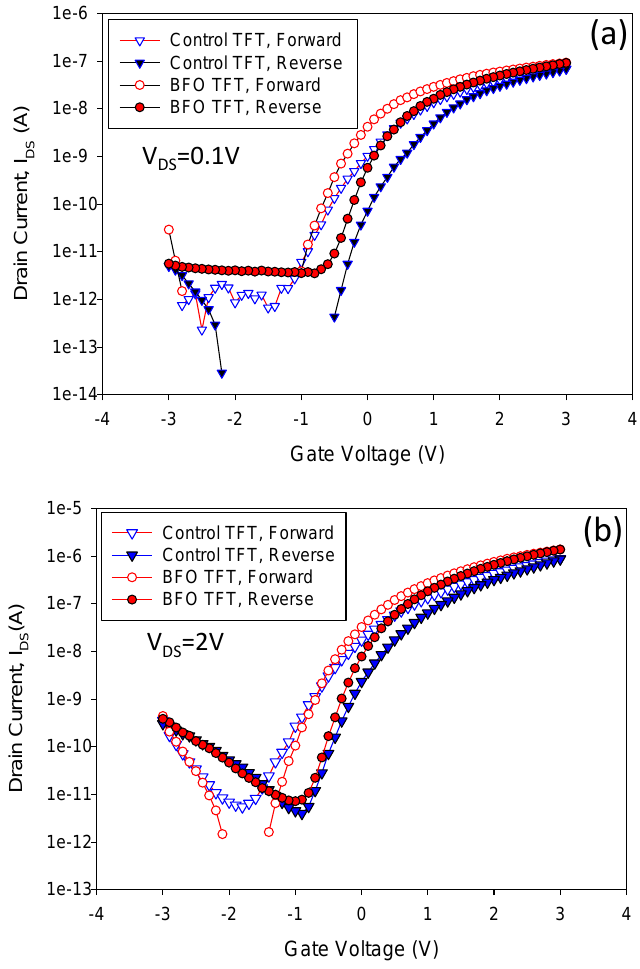
Figure 4. ( a ) I DS -V GS transfer characteristics at V DS of 0.1 V for control TFT (L = 5 μm, Weff = 60 nm) and 550-BFO TFT. ( b ) I DS -V GS transfer characteristics at V DS of 2 V for control TFT and 550-BFO TFT.